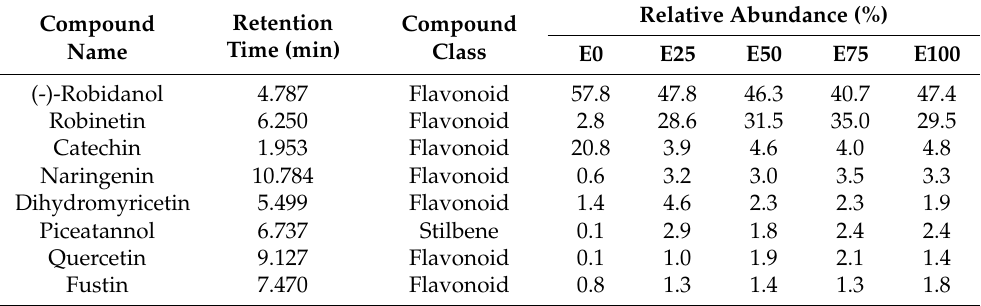
Table 3. Chemical constituents of I. bijuga